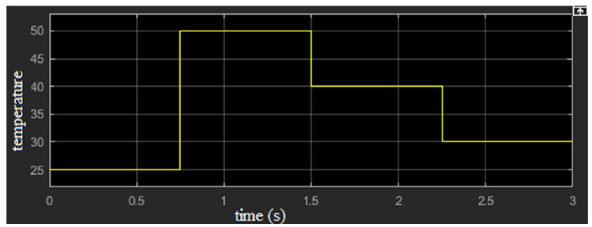
Fig. 8 Change in temperature profile